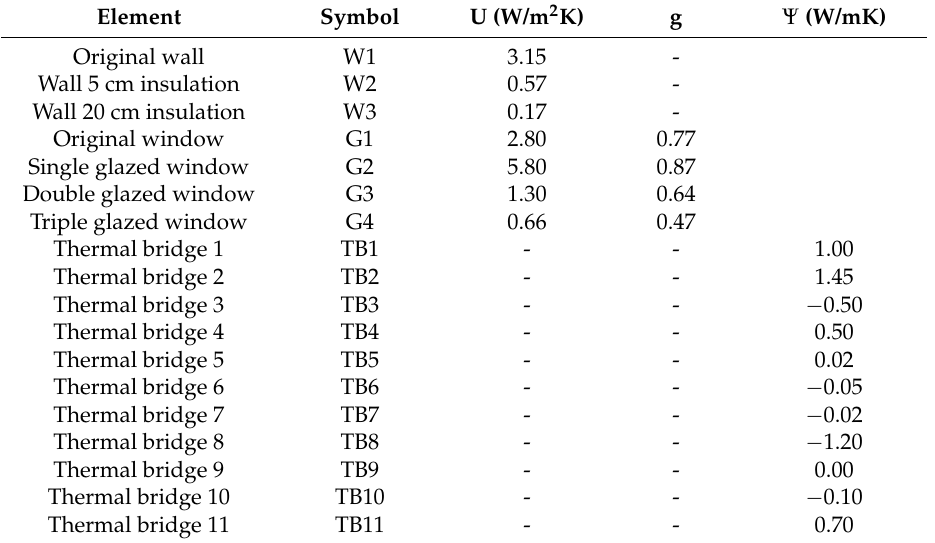
Table 1. Thermal properties of the elements considered in the different verandas configurations. Element Symbol U (W/m 2 K) g Ψ